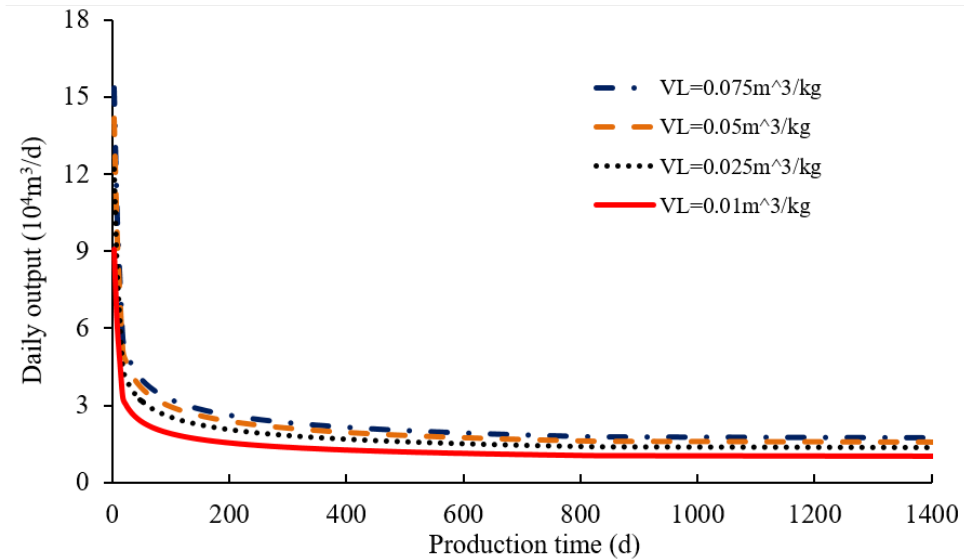
Figure 5. The influence of Langmuir volume on the daily gas production.